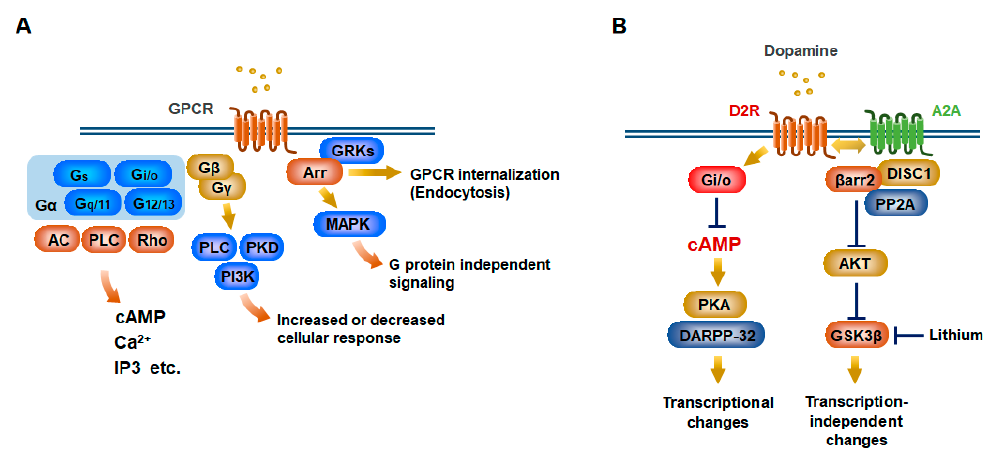
Figure 1. Schematic illustration of G protein-coupled receptor (GPCR) signaling. ( A ) Canonical G protein-coupled receptor (GPCR) signaling occurs through heterotrimeric G proteins (G α , G β ,